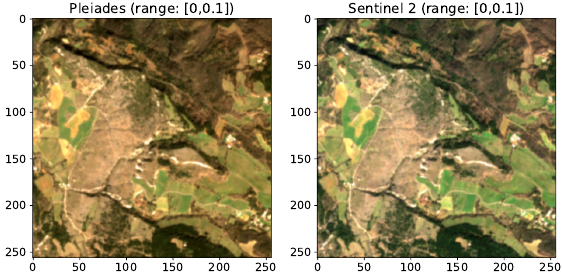
Figure 1. RGB composition of Top of Canopy surface reflectances from Pleiades and Sentinel-2, on the same acquisition date with same